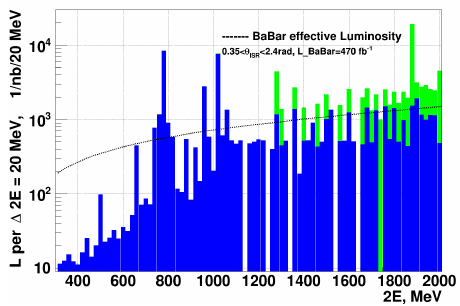
Figure 3. Integrated luminosity collected by CMD-3 at di ff erent energies with 20 MeV energy bins. Blue — 2011–2013 runs, green — 2017 run. The line shows the e ff ective ISR integrated lumi- nosity at